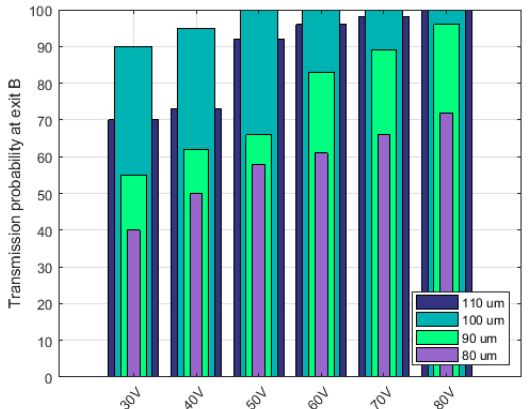
Figure 7. Effects of constriction clearance / size, i.e., diameter and DC voltage on the transmission probability of ADCs. Diameter of the constrictions were varied—80, 90, 100, and 110 μm keeping the number (#) of constrictions fixed, i.e., 5 at a given time. Perfect sorting was observed for constriction diameter of 100 μm at voltages >50 V DC .